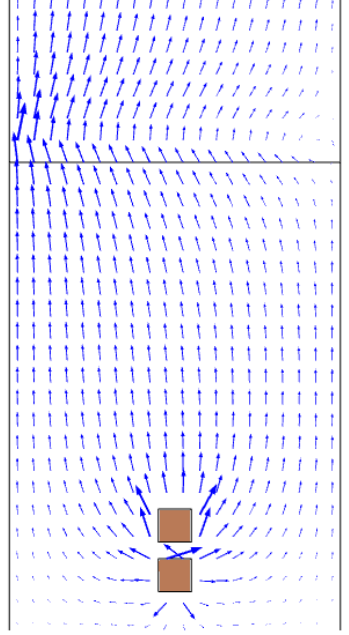
Figure 12. Velocity vectors in bubble growth in vertical